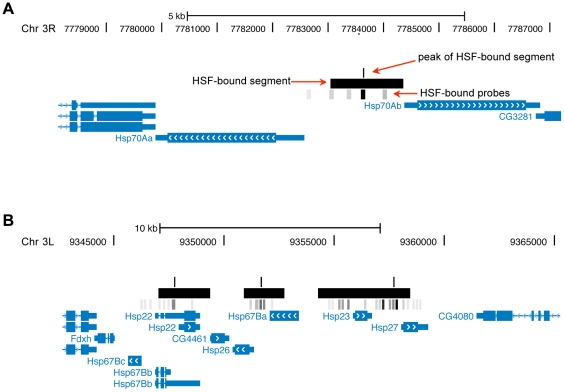
Representation of select genomic regions bound by HSF.This image, generated using the UCSC Genome Browser, illustrates the chromosome region represented in bp (according to release 4.2 of the Drosophila genome) as indicated at the top. Genes are depicted as blue boxes with the thick and thin parts representing exons and introns respectively. Arrows (either blue or white) within the gene indicate the direction of transcription. Large black and small grey boxes represent HSF-bound segments and probes respectively identified by Chip Analytics (Agilent Technologies). Darker grey shading is used to represent probes with higher fold-enrichment relative to WCE. The single black line above bound segments indicate the position assigned as the segment peak and is also the center of the probe with the lowest P[Xbar]. (A) A single HSF-bound segment is found in the region encompassing Hsp70A. The probe with the lowest P[Xbar] is located near the numerical center of the bound segment. (B) Three HSF-bound segments are found in the region encompassing the small HSP genes. It is likely that these segments represent more than 3 distinct HSF-binding sites, however, a single peak per segment has been assigned potentially resulting in an underestimation of the number of individual binding sites in this region.